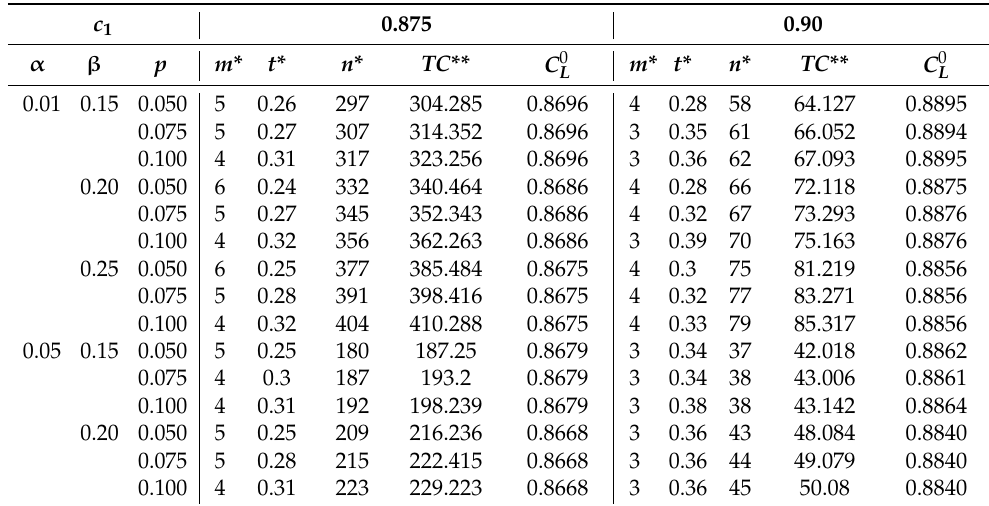
Table 3. The optimal ( m * , t * , n * ), total cost TC and critical value for c 1 = 0.875, 0.90 , α = 0.01, 0.05, 0.1,